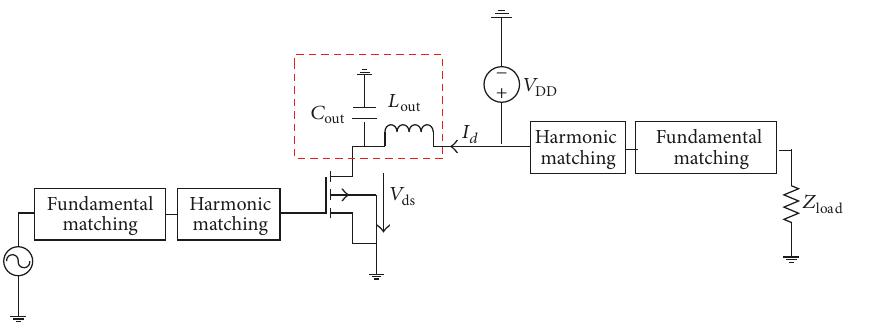
Figure 1: Circuit diagram of a Class-F power amplifier model.